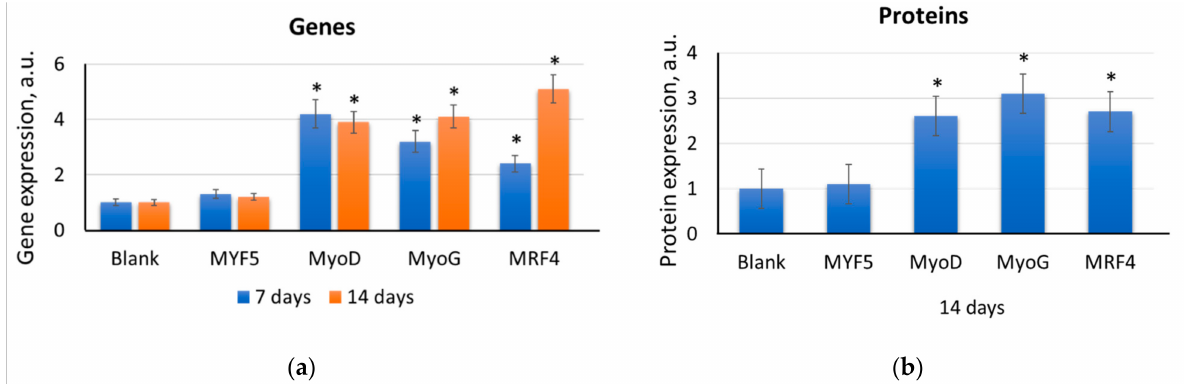
Figure A1. The expression of genes ( a ) and proteins ( b ) of myogenic differentiation induced by the standard differentiation kit (a positive control); the exposition times are shown in the figure. The gene RNA amount was the mean value for three experiments related to the blank; the TBP gene was used as an internal reference gene; (*) denotes significant differences compared to blank cells, p < 0.005, in a Mann–Whitney test. In blank experiments, cells were incubated without the differentiation